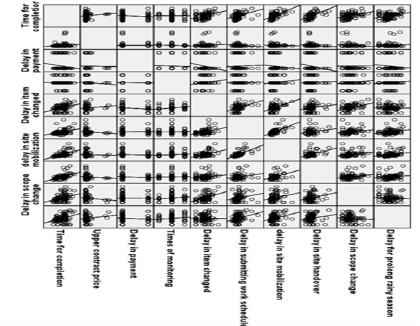
Fig. 3. Scatter matrices show linear relationships among dependent variable time for completion and the independent variables